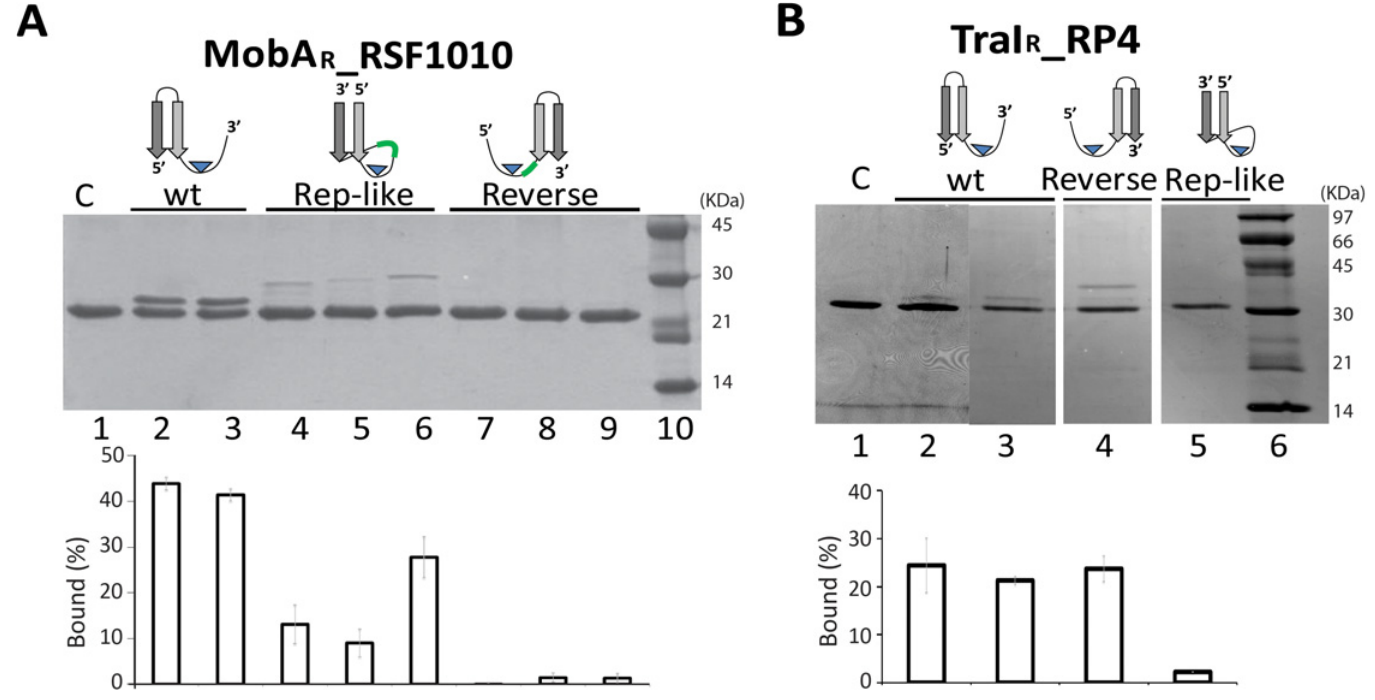
Fig 3. Novel designs for DNA substrates of model single-Y relaxases. (A) SDS-PAGE of MobA R _RSF1010 with its targets. 7 μ M MobA R was incubated with 15 μ M of different oligonucleotides. Lane 1, MobA R . Lanes 2 and 3, wt oligonucleotide WQ(30+7) and a substrate that lacks the upper-hairpin nucleotides of the IR WQ(23+7). Lanes 4, 5 and 6, Rep-like oligonucleotides HQ(16+16),HQ(16+19) and HQ(16+22), respectively. Lanes 7, 8 and 9 reverse substrates RQ(8+28), RQ(8+34) and RQ(8+40). Lane 10, molecular weight ladder. (B) SDS-PAGE of TraI R _RP4 with its targets. 1.5 μ M TraI R was incubated with 15 μ M of different oligonucleotides. Lane 1, TraI R ; lane 2, wt substrate WP(15+6); lane 3, wt substrate WP(24+8); lane 4, reverse substrate RP(8+24) and lane 5, Rep-like substrate HP(14+14). Molecular weight ladder is shown on Lane 6. Bar graphs with the quantification of covalent complexes are shown below the SDS-PAGE gels. Data showed mean ± s.d. of three independent experiments.